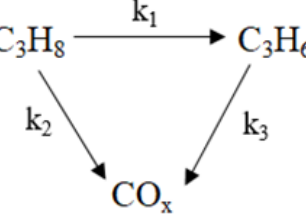
Figure 6. Reaction Network for Propane Oxidative Dehydrogenation Using aVO x /ZrO 2 - γAl 2 O 3 Cat- alyst. Adapter from [16]. Copyright: 2018, Copyright Owner’s: American Chemical Society. For the PODH postulated reaction, the partial pressures of various chemical species obtained in the CREC Riser Simulator, were compared with the partial pressures resulting from the numerical solution of Equation (4). This evaluation is reported in Figure 7, with a best set of adjusted kinetic parameters that have reduced spans and low cross-correlation. This is also reported in Table 4.